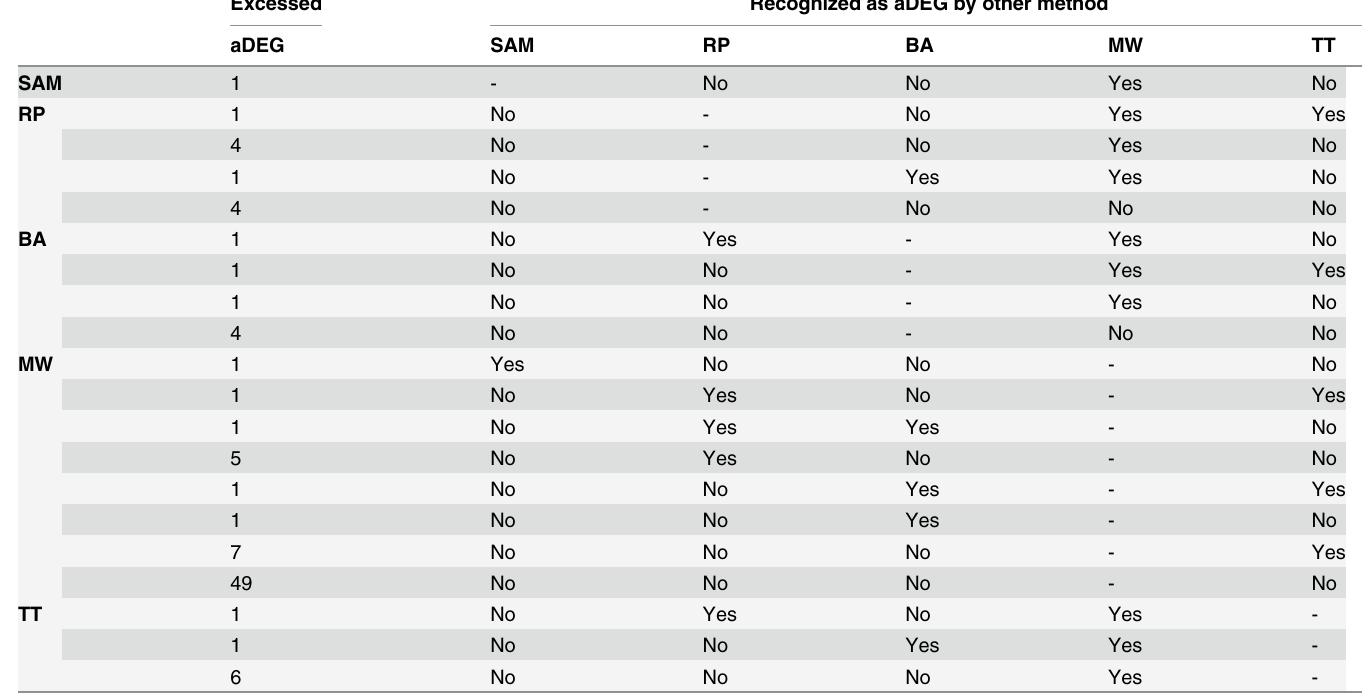
Table 6. Summary of excessed aDEGs by each method. Excessed Recognized as aDEG by other